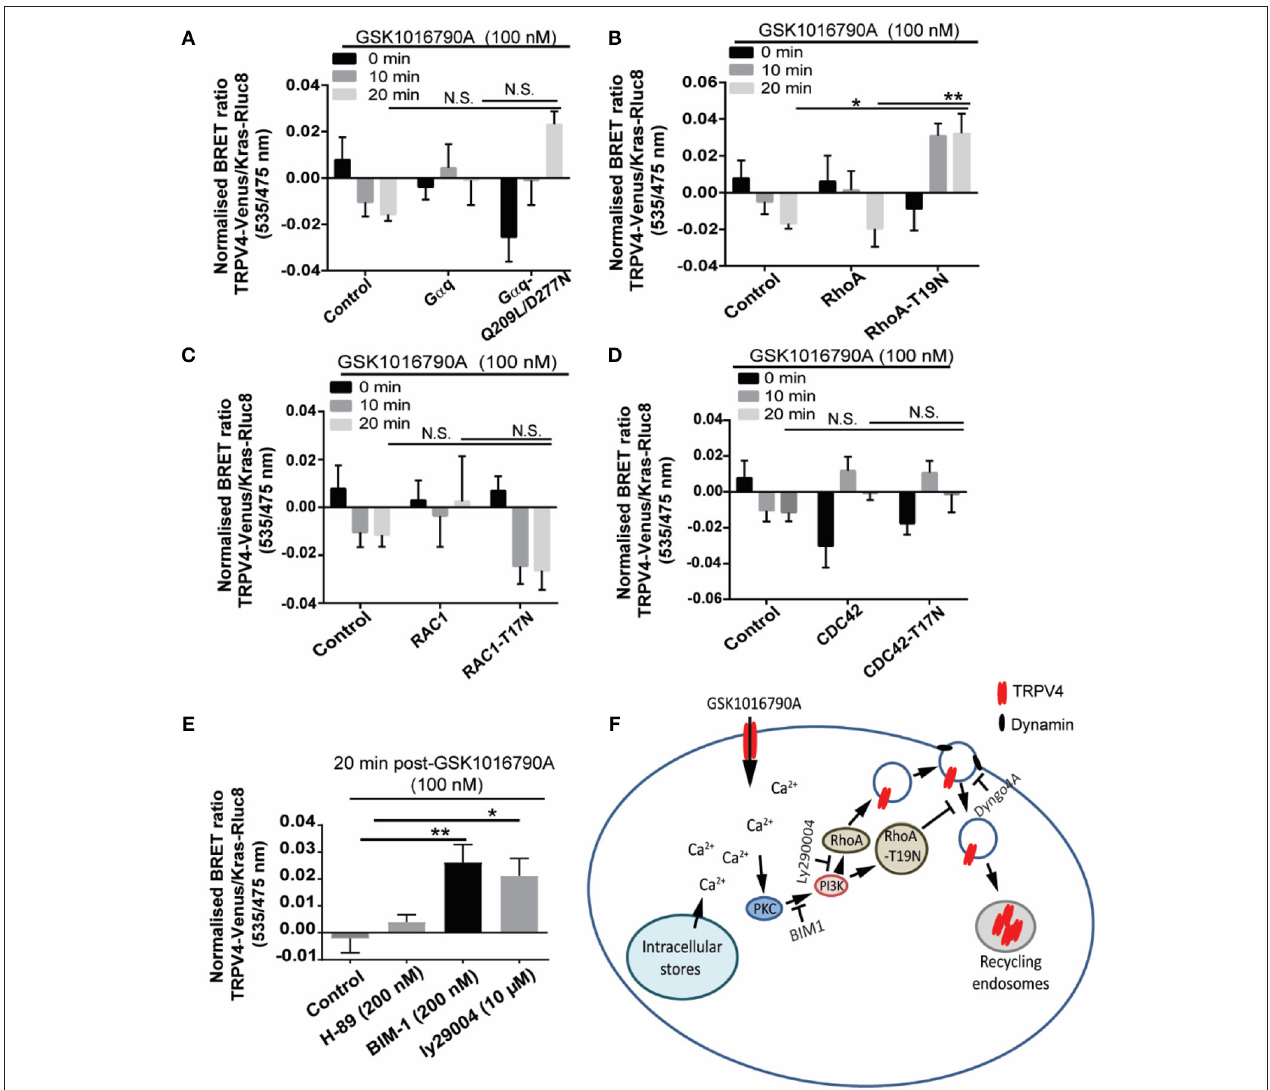
FIGURE 6 | GSK1016790A induced TRPV4 endocytosis is controlled via PKC/PI3K and RhoA signaling pathways. (A–D) BRET assay showed that over-expression of dominant negative RhoA increased the BRET ratio between TRPV4 and Kras after 20min treatment with GSK1016790A while there was no difference between dominant negative and wild-type of RAC1, CDC42, and G α q. (E) BRET assay showed that inhibition of PI3K with 10 µ M of Ly294002 (PI3K inhibitor) and 200nM of BIM1 (PKC inhibitor) increased the net BRET ratio between TRPV4 and Kras after 20min treatment with GSK1016790A while inhibition of PKA using 200nM of